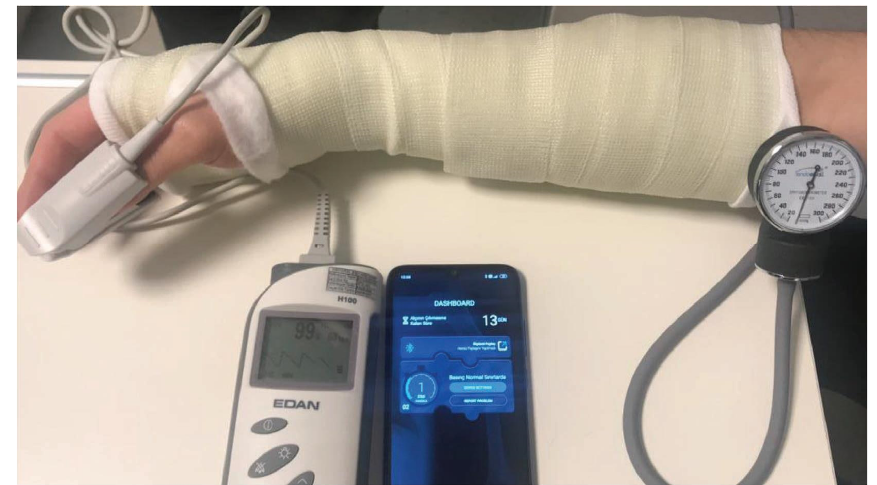
Figure 2: Determination of cut-of values with pulse oximetry.